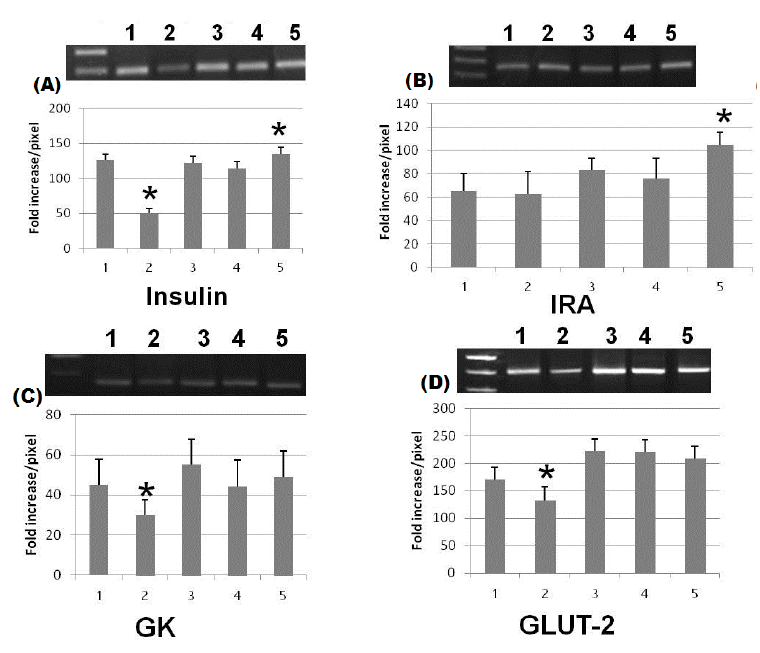
Figure 2. Gel picture of the examined genes bands after Agarose gel electrophoresis ( A ) Insulin gene; ( B ) Insulin receptor A gene; ( C ) Glucokinase gene; ( D ) Glucose transporter protein 2; and ( E ) Glycraldehyd 3 phosphate dehydrogenase. 1, control; 2, diabetic; 3, diabetic + ZnONPs; 4, diabetic + SNPs; and 5, diabetic + insulin (column with ( * ) are significant at p <